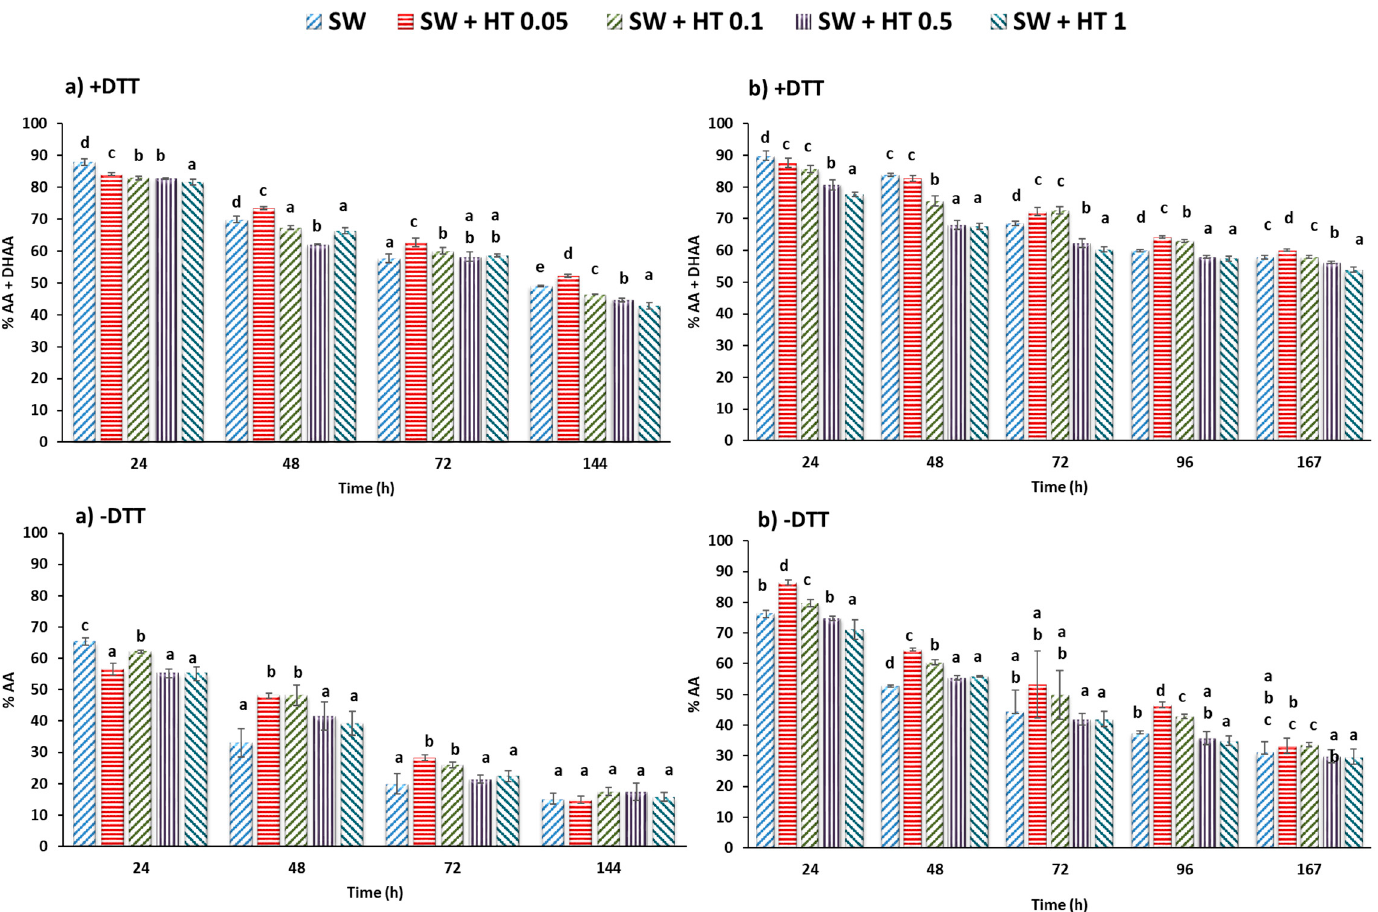
Figure 2. Evolution of vitamin C in strawberry (SW) puree of the Calinda varieties with different concentrations of HT added (0.05, 0.1, 0.5 and 1 mg/g strawberry) ( a ) and in the Inspire variety ( b ) with DTT (+DTT = total ascorbic [AA+ADHA]) and without DTT ( − DTT only acid ascorbic, AA) during storage at 4 °C. Influence of HT added to different concentrations. The data are shown as mean ± SD of quadruplicates. Letters (a–d), indicate different differences between groups with p < 0.05.